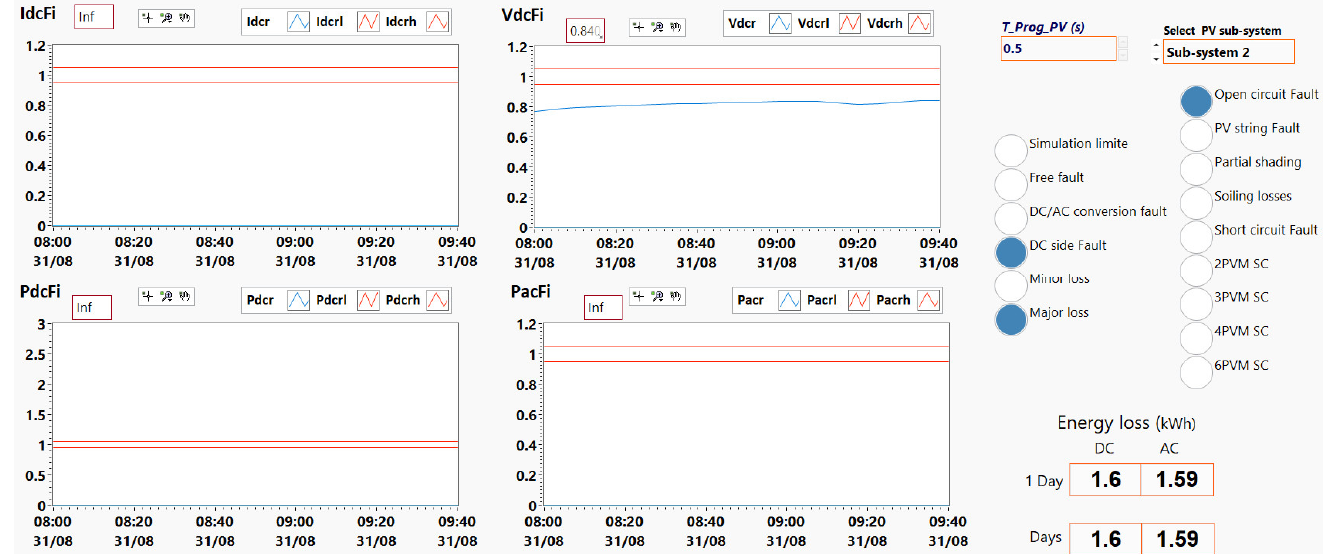
Figure 28. Recognition of open circuit fault in PV subsystem